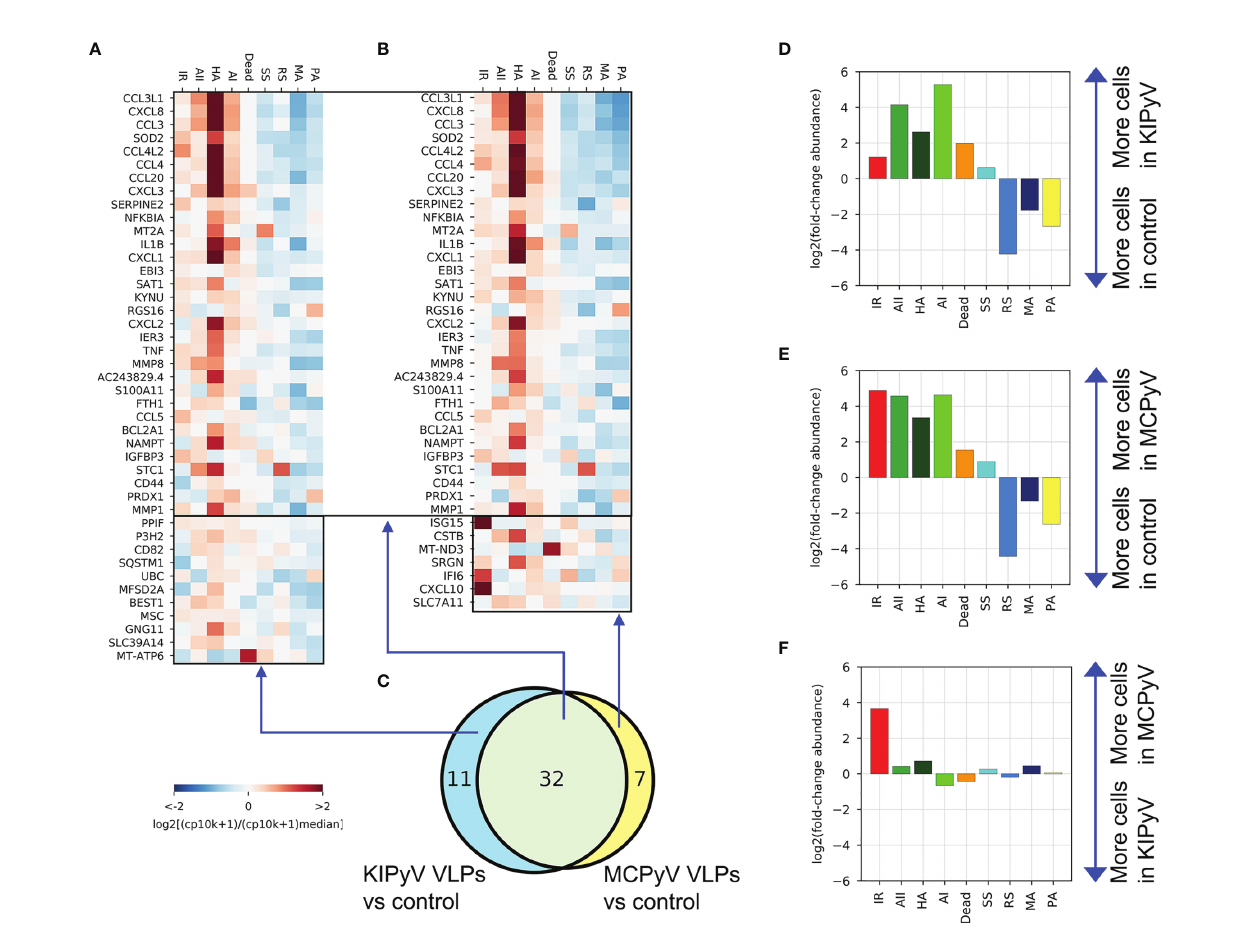
FIGURE 10 | Genes enriched in both KIPyV and MCPyV VLP-treated cells have a very similar expression pattern across the populations observed, except for the interferon-response (IR) population. (A) Expression of genes identi fi ed as enriched in KIPyV VLP-treated macrophages in the bulk-like analysis ( Figures 8C, D ) at the individual population level in KIPyV VLP-treated macrophages. (B) The equivalent of A for the MCPyV VLP-treatment condition. (C) Same Venn diagram as in Figure 8D . (D – F) Fold changes in population abundance in pairwise comparisons of the three conditions (Control, KIPyV VLP, and MCPyV